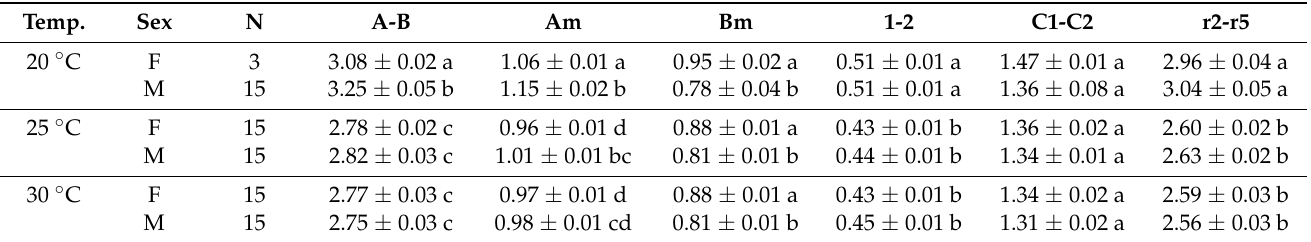
Table 2. Length (average ± standard error, in mm) of the different biometric wing measurements of H. capensis (F: females, M: males) at 20 °C, 25 °C and 30 °C. No adults emerged at 18 °C. Temp. is temperature, N is the sample size. Different letters indicate statistically significant differences (LSD test, p < 0.05).